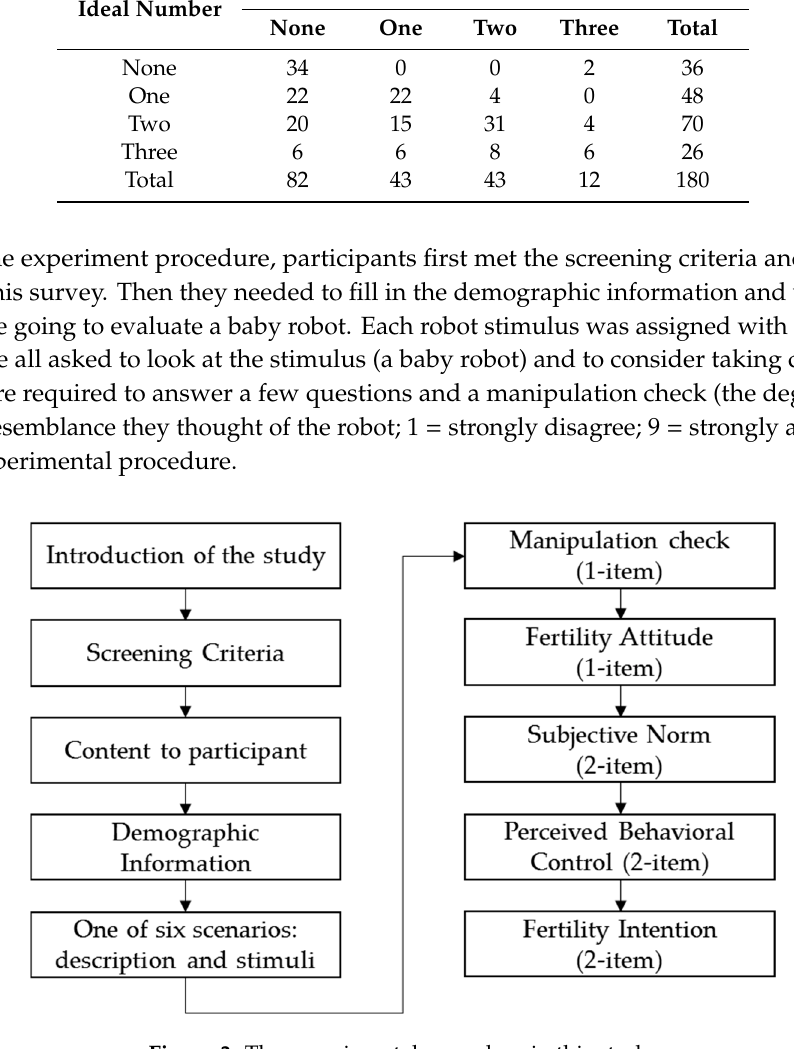
Table 4. The mean of different variables and their correlations.